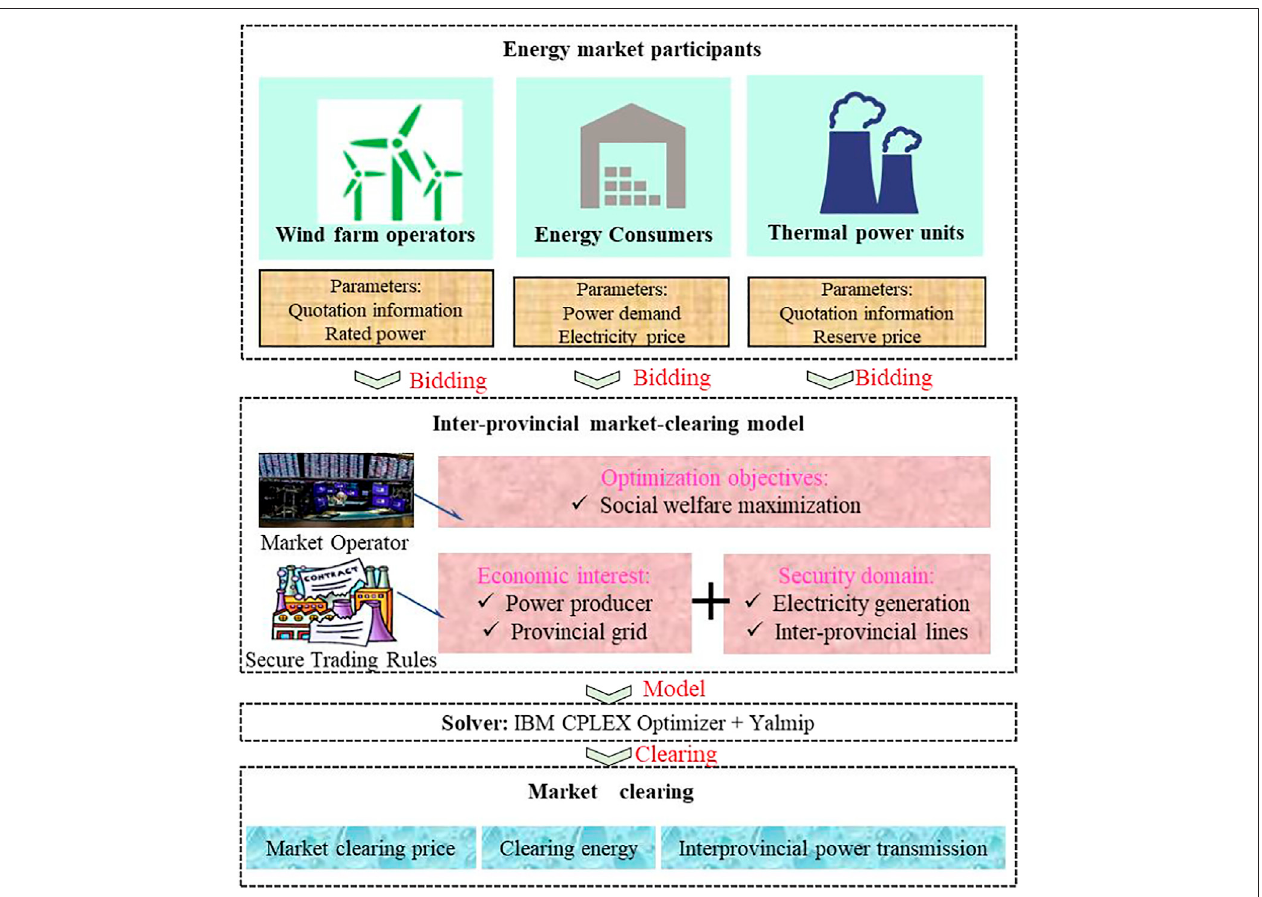
FIGURE 3 | Solution process of an inter-provincial market-clearing